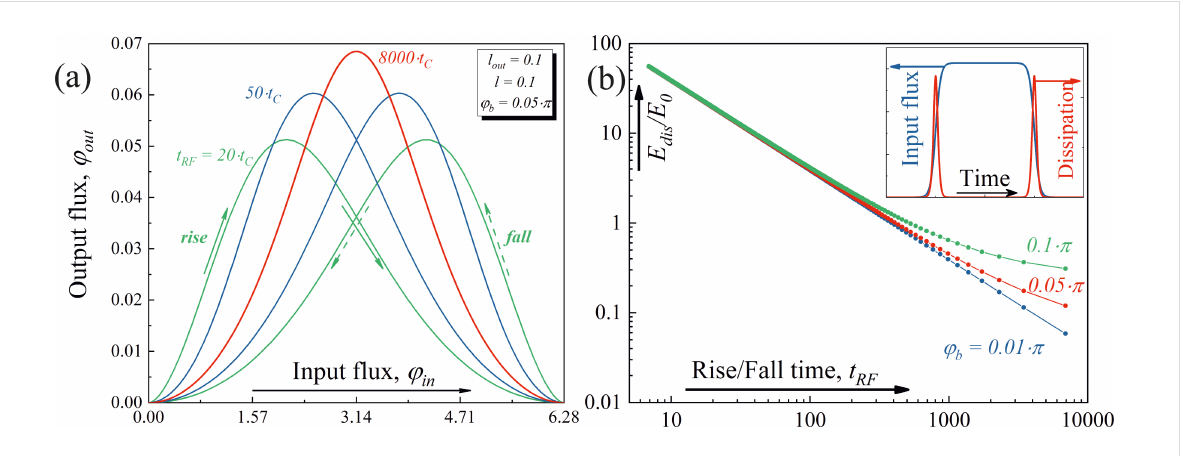
Figure 4: (a) Dynamic transfer function of a Gauss-neuron for a trapezoidal external signal for different values of the rise/fall times of the signal t RF and (b) energy dissipation, normalised to the characteristic energy E 0 = Φ 0 I C /2 π , as function of the rise/fall time of the input signal for different bias fluxes: φ b = {0.01, 0.05, 0.1} π . The insert demonstrates the form of temporal dynamic for input flux and dissipation. If the critical current for Josephson junctions I C is equal to 100 μ A and φ b = 0.05 π than E dis ≈ 0.01 aJ for t RF = 6 ns (corresponds to approx. 1700 t C